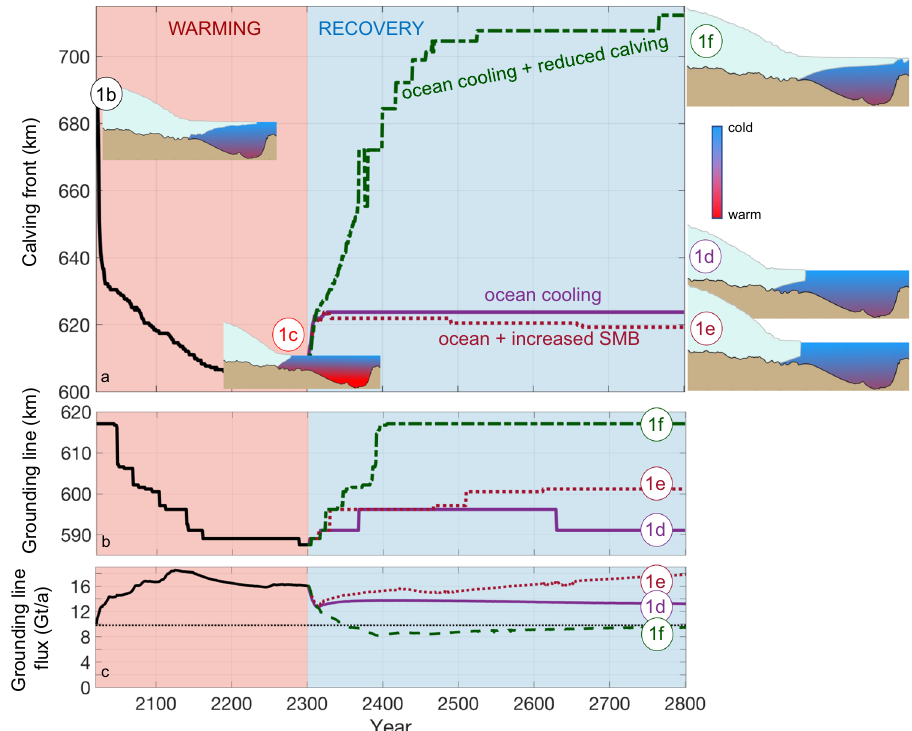
Fig. 2 Response of Petermann Glacier Ice Shelf to future climate warming and subsequent cooling pathways. Evolution of Petermann ’ s a ice-shelf calving front, b grounding line and c grounding-line fl ux, for the forcings compared in Fig. 1 during the 2 °C ocean warming 19 and recovery experiments. An ocean cooling alone does not lead to recovery, neither does ocean cooling + increased surface mass balance (SMB). In contrast, an ocean cooling and reduced calving allow the ice shelf to recover. In c , the dashed line represents the present-day observed fl ux 36 . The labels (1b – 1f) refer to the panels in Fig. 1. Modelled glacier geometries and schematic ocean temperatures are shown in a for each associated